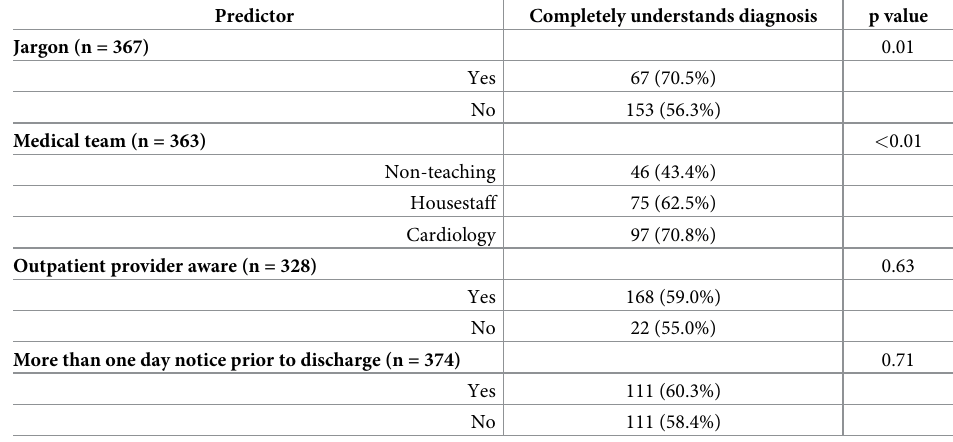
Table 2. Bivariate analysis examining systems predictors to completely understanding hospital diagnosis.